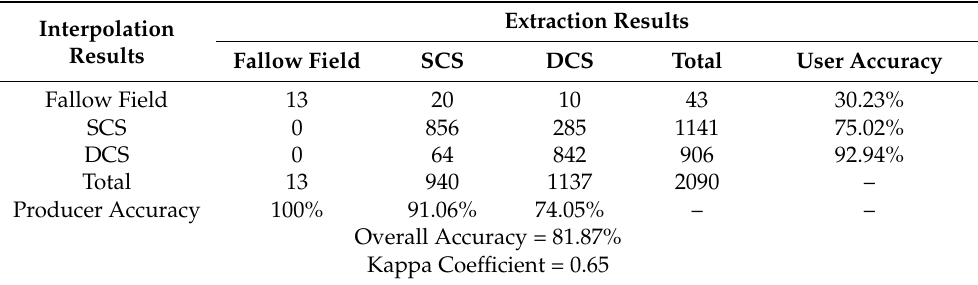
Table 2. Cross-validation error matrix for the cropping systems used on the